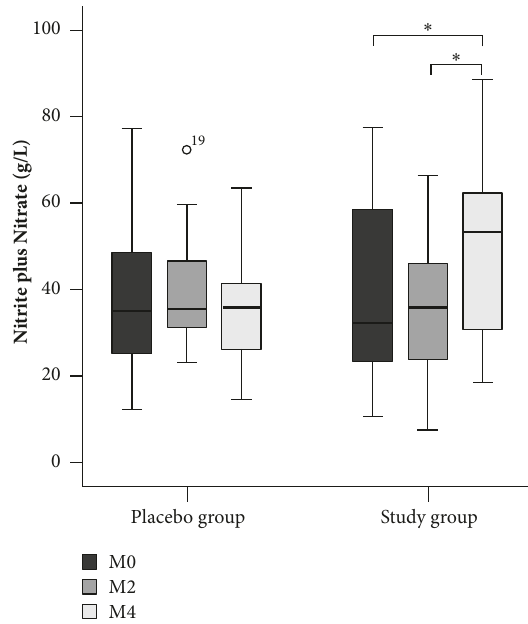
Figure 1: Comparison between the levels of nitrite plus nitrate in the different treatment groups and at the different moments evaluated. Two-way repeated measures ANOVA. ∗𝑝 ≤ 0.001 in the comparison between M0 and M4 and M2 and M4. M0 (timepoint before receiving placebo or L-arginine supplement); M2 (timepoint two months after receiving placebo or L-arginine supplement); M4 (timepoint four months after receiving placebo or L-arginine